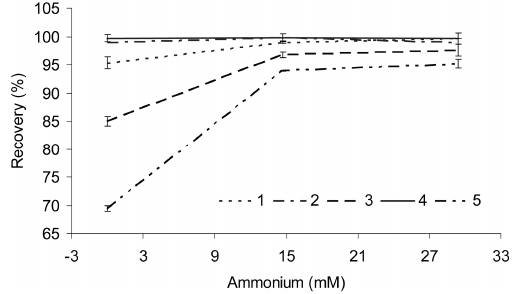
Figure 1. Effects of ammonium hydroxide on the recoveries of flavones ( n = 3). Peaks: 1 = scutellarin; 2 = baicalin; 3 = wogonoside; 4 = baicalein; and 5 = wogonin.